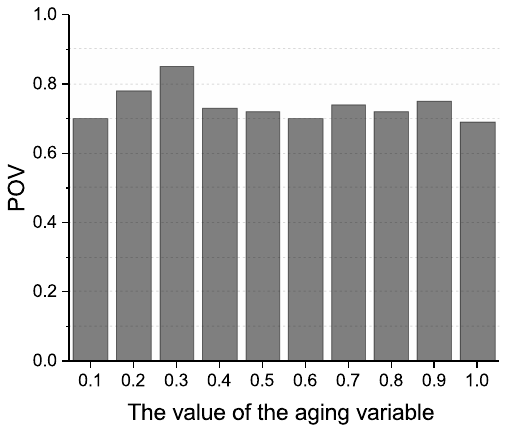
Figure 5. The probability of the destination profile receiving Prelearn messages.